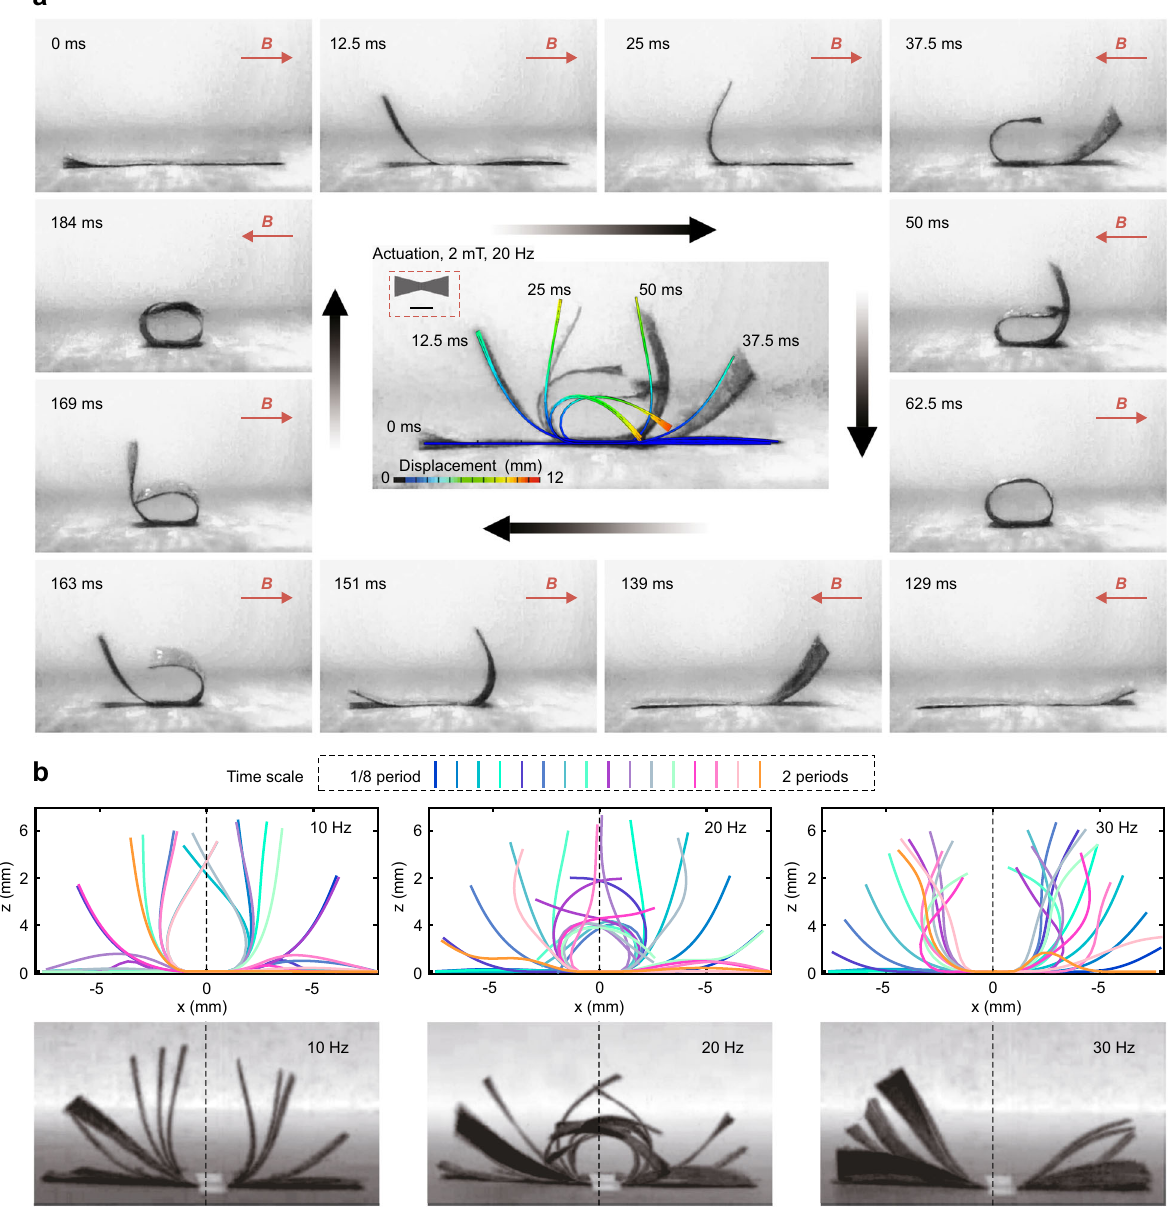
Fig. 3 Asynchronous strongly nonlinear dynamic actuation of a two-arm trapezoid-shaped soft robot. a Experimental and simulated robot actuation triggered by a magnetic fi eld at 20 Hz (Supplementary Movie 7). The central fi gure shows the traces of the actuation predicted by the simulation compared to the experimentally observed ones. The surrounding panels show the dynamics of the soft robot actuation for one full period. b Comparison of the simulated with the experimental results of a two-arm robot actuation triggered by magnetic fi elds at 10, 20, and 30 Hz, respectively. Cross clapping is allowed only for frequencies close to 20 Hz. For these experiments, the middle point of the robot is fi xed on a substrate. Scale bars, 0.5 arm remains bent (delayed response with respect to the actuation soft robot . The simulation of the two-arm bow-tie-shaped robot sequence). Such cross-clapping motion is asynchronous strongly predicts a fast, repeatable, and precisely controlled motion pattern nonlinear compared to the existing soft robots. We provide a upon square wave magnetic fi eld actuation (20 Hz), which is dis- schematic fi gure to illustrate the difference of different motion tinct from trivial bending. This pattern is akin to a cross-clapping patterns (Supplementary Fig. 16). The snapshots of the motion motion of a human (colored lines in Fig. 3a). In this experiment, we trajectory in Fig. 3a show the cross-clapping movement sequence in apply a regular alternating magnetic fi eld, however, the robot detail (Supplementary Movie 7). The robot lays fl at on the substrate responds in an unconventional and unexpected fashion. Usually, initially, and then the left arm bends from 0° to 82° in 25 ms, while the robot sequentially moves its left and right arms following the the right arm does not respond when the magnetic fi eld (2 mT, period of the magnetic fi eld. Upon performing the cross-clapping 20 Hz) is applied. Next, the right arm starts to deform to 75.8 o until 50 ms, touching the tip of the left arm, which continuously bends to motion, the robot bends its left arm followed by the bending of its 180° at the same time. The right arm completes its movement until right arm and then continues to unfold the right arm while the left